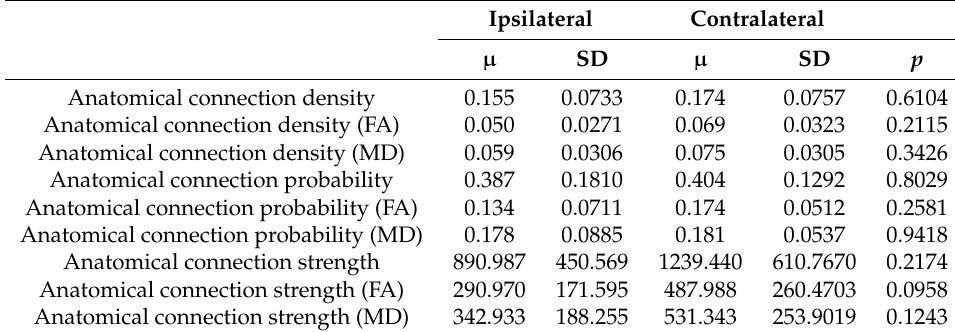
Table 6. DTI values in optic radiation. Anatomical connectivity.